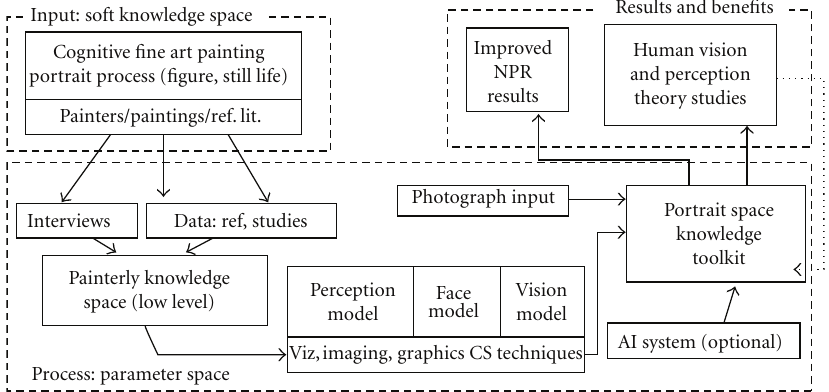
Figure 1: The process chart for making the Painterly system (from [14]).